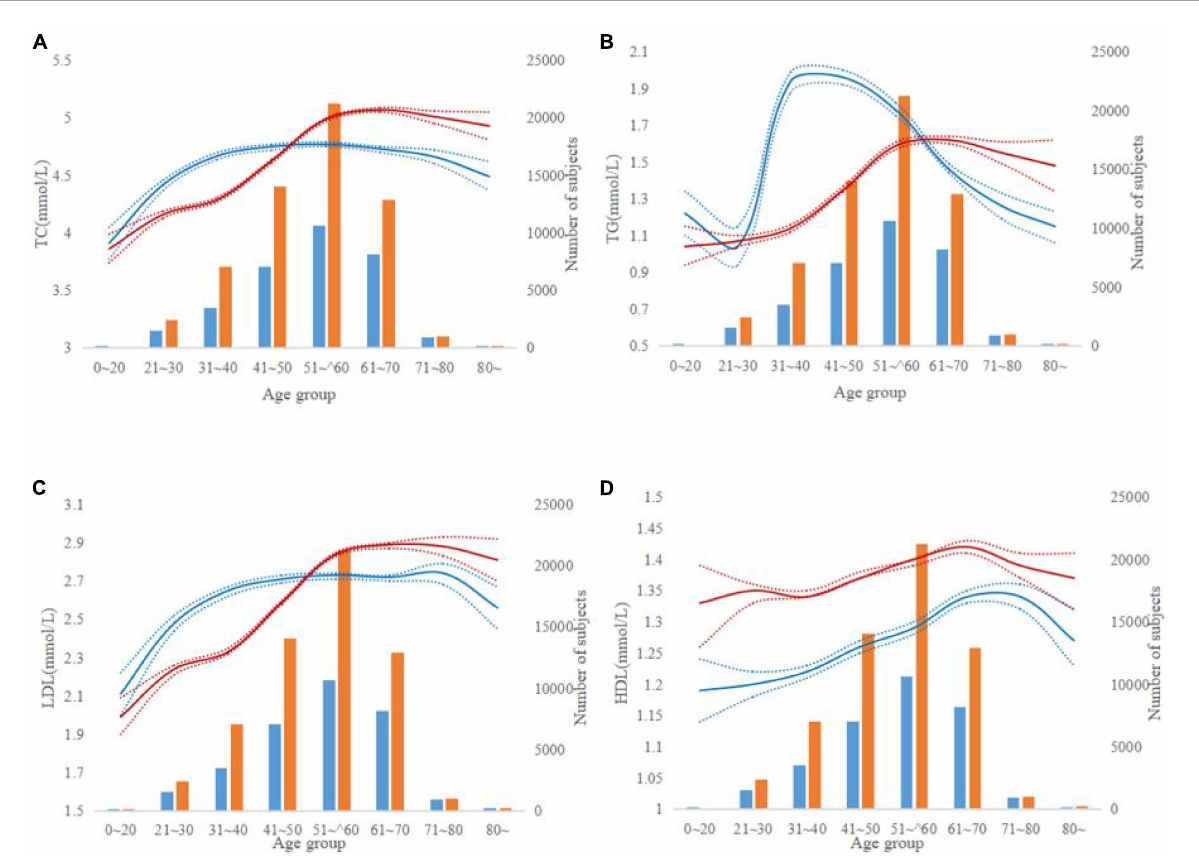
FIGURE1 Lipid levels according to age groups. (A–D) The red and blue lines indicate trends for males and females, respectively. The dotted line represents a 95% confidence interval and the bars represent the number of males and females. (A–D) Represent TC, TG, LDL, and HDL levels by age